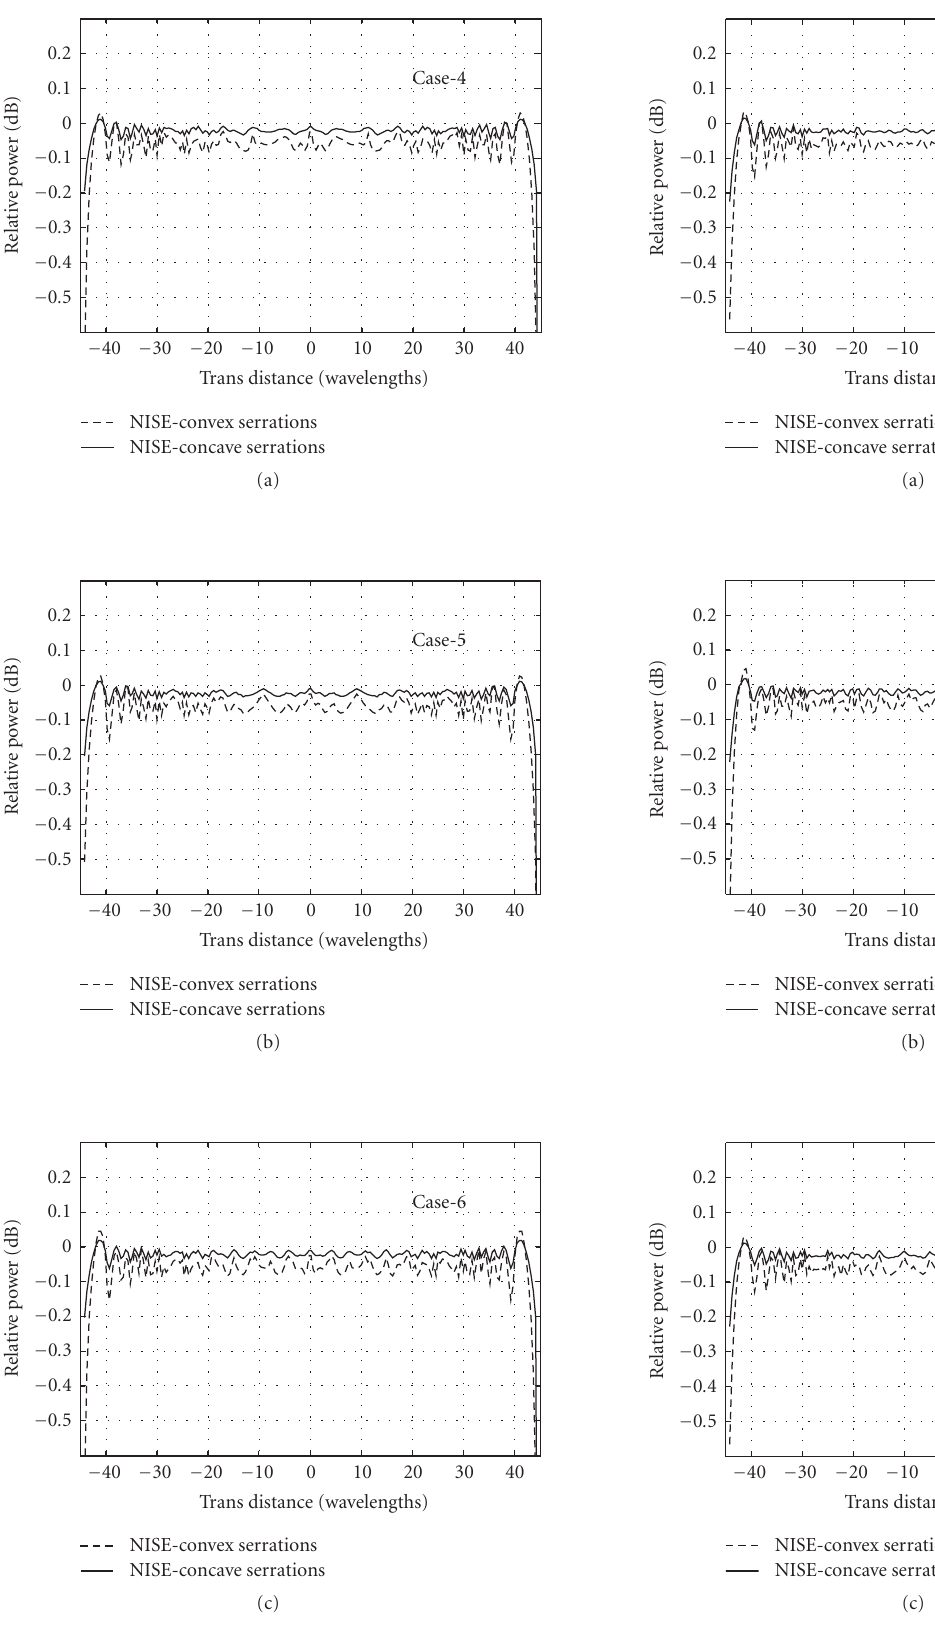
Figure 7: Fresnel-zone field for 90 λ × 90 λ NISE-convex and NISE- concave serrated CATRs for cases 7, 8, and